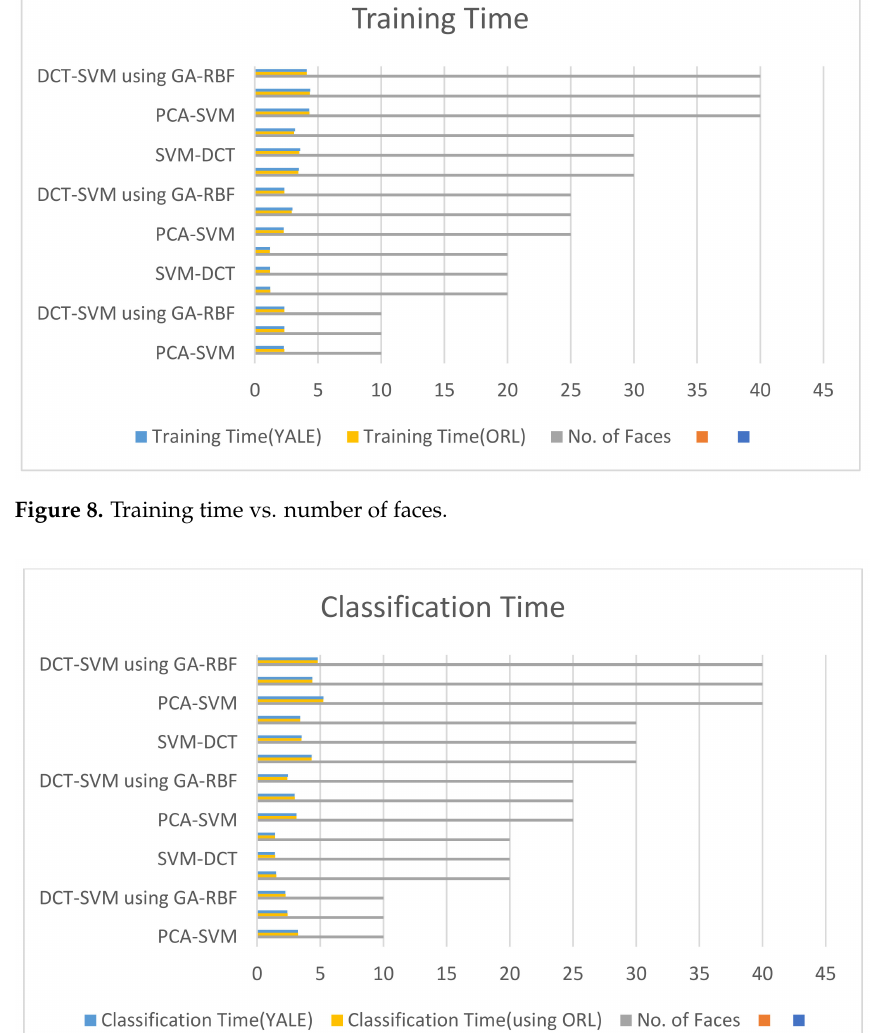
Figure 9. Classification time vs. number of